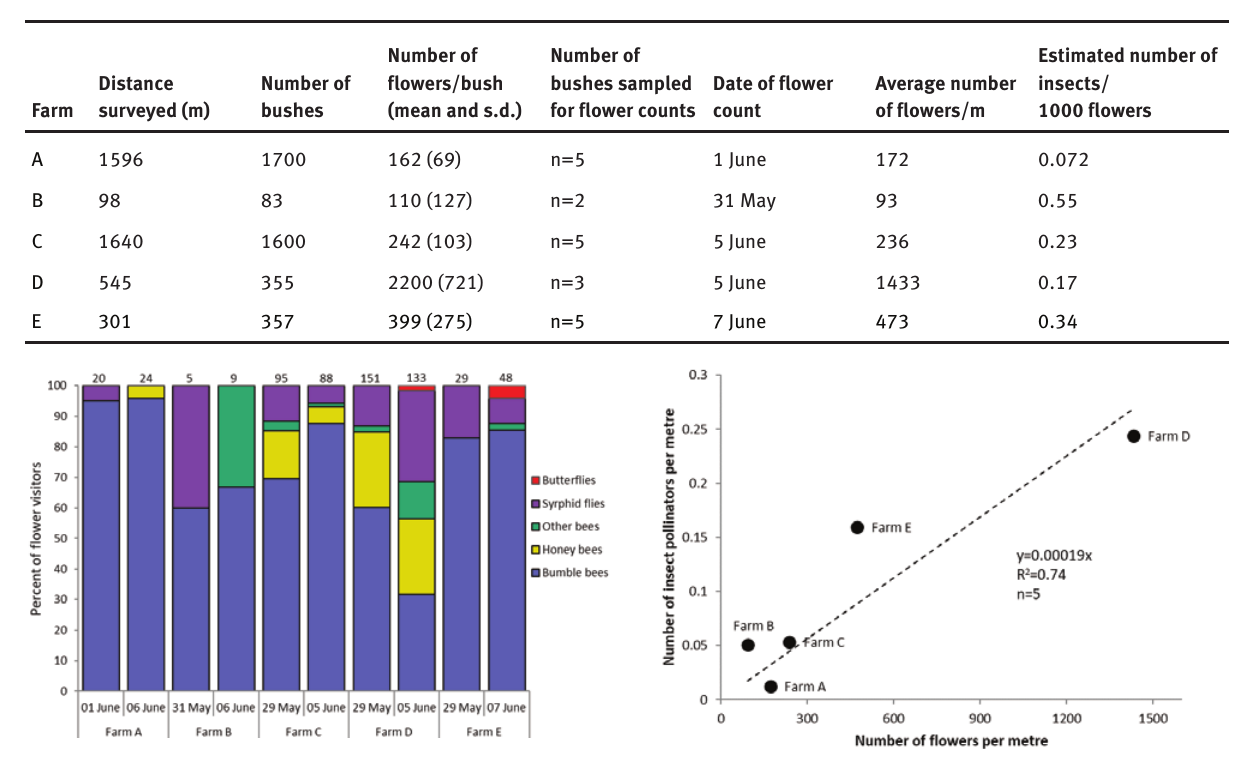
Table 3: Characteristics of transects at each farm and estimated number of flower visitors.